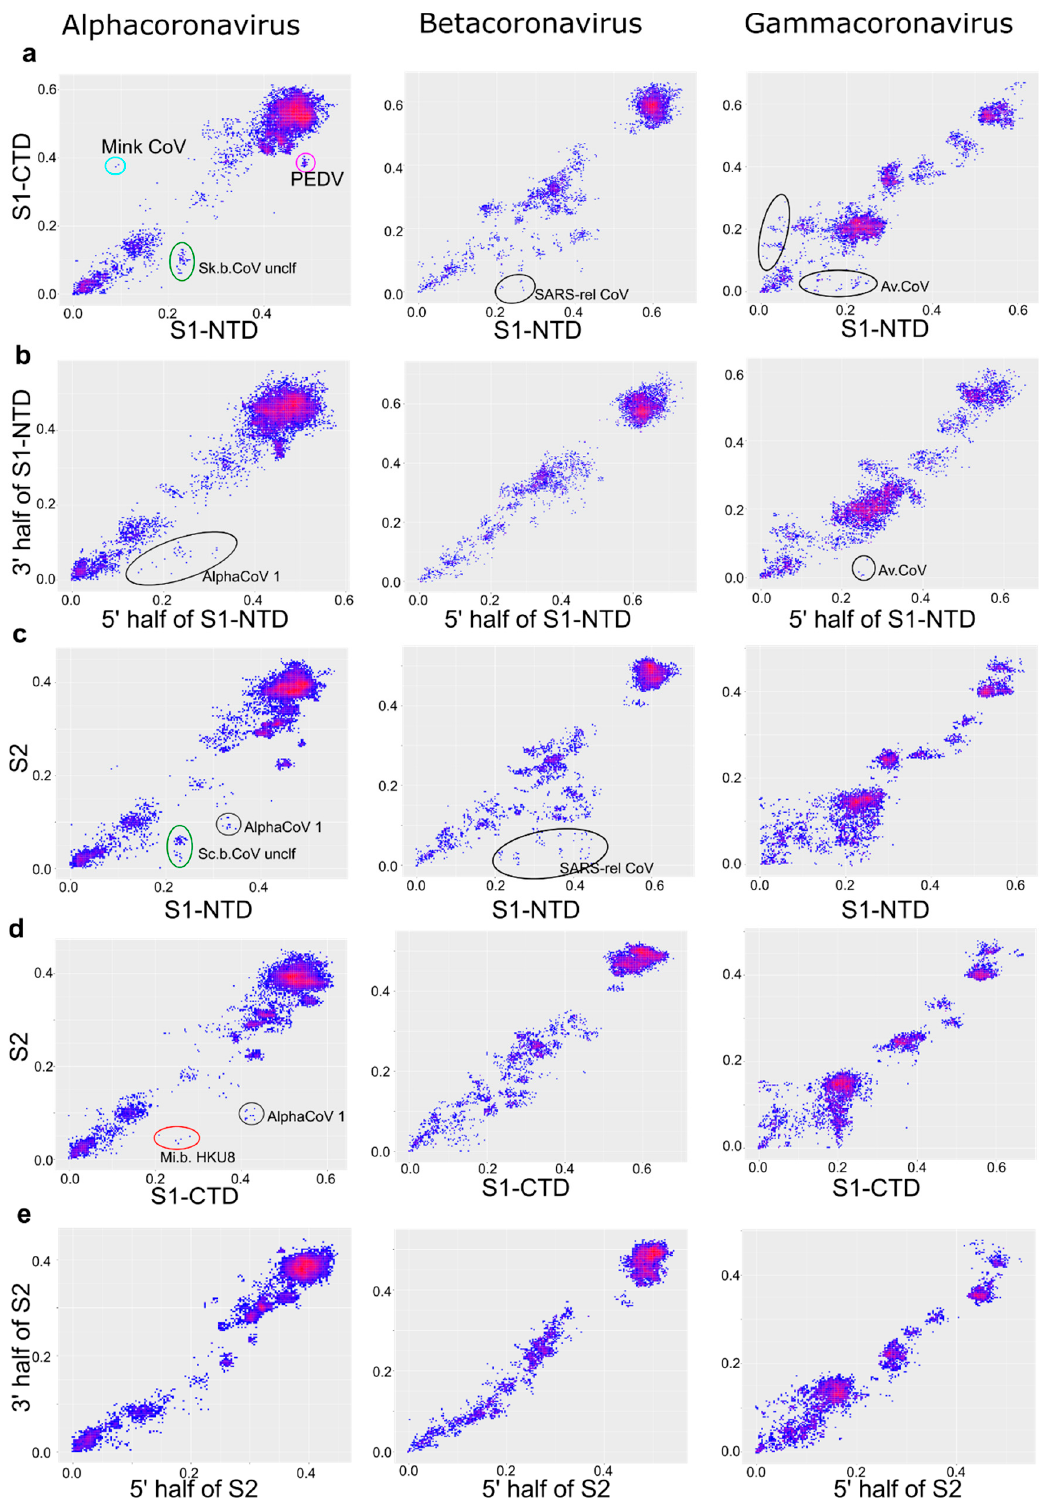
Figure 6. Recombination within domains of spike is less pronounced than between them. Correspondence of pairwise nucleotide distances in different regions of the spike protein: S1-NTD and S1-CTD domains ( a ), two halves of S1-NTD domain ( b ), S1-NTD domain and S2 region ( c ), S1-CTD and S2 region ( d ), two halves of S2 region ( e ). AlphaCoV 1, Alphacoronavirus 1 ; Mi.b.HKU8, Miniopterus bat coronavirus HKU 8 , Sc.b.CoV 512, Scotophilus bat coronavirus 512 ; SARS-rel. CoV, SARS-related coronavirus ; Av.CoV, Avian coronavirus. Points that correspond to virus pairs that underwent recombination and are discussed in the text are marked with circles.